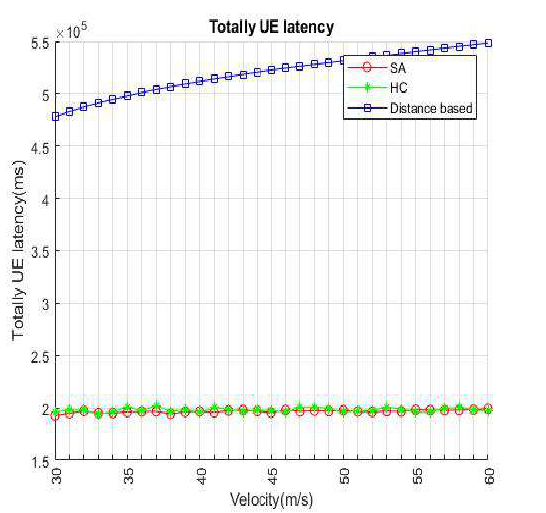
Figure 13. Total VUE latency per